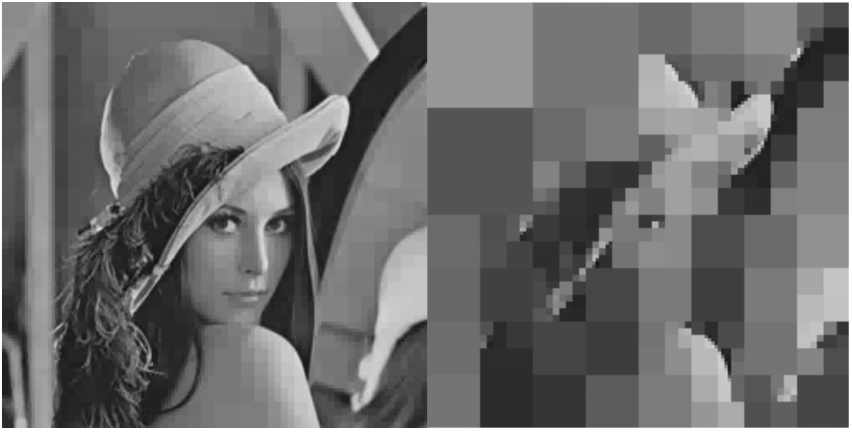
Figure 14 . Initial Transmitted Image Frame ( t = 0 s—left side)—Converged Transmitted Image Frame ( t = 350 s—right side).